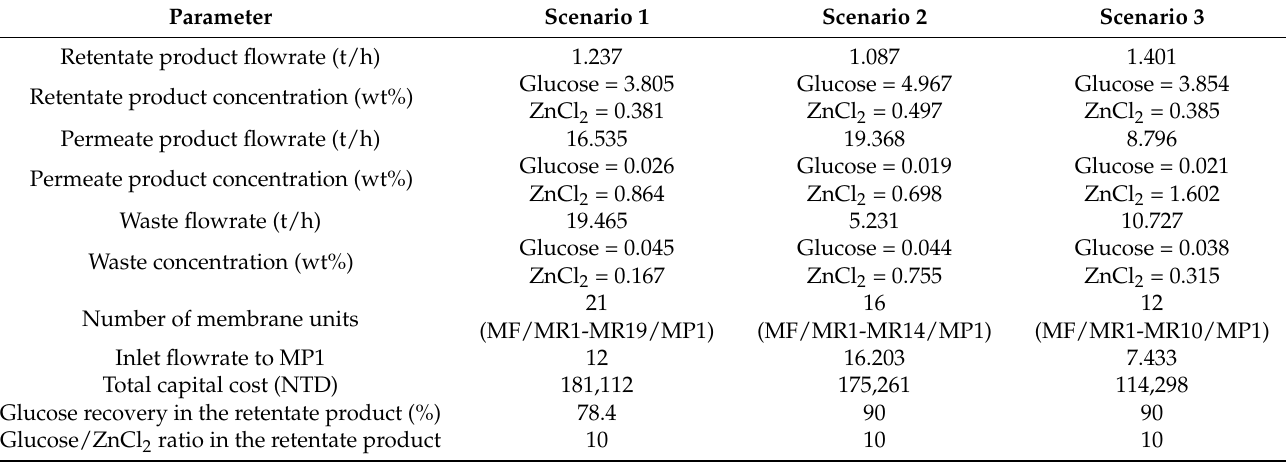
Table 2. Main results for case 1.